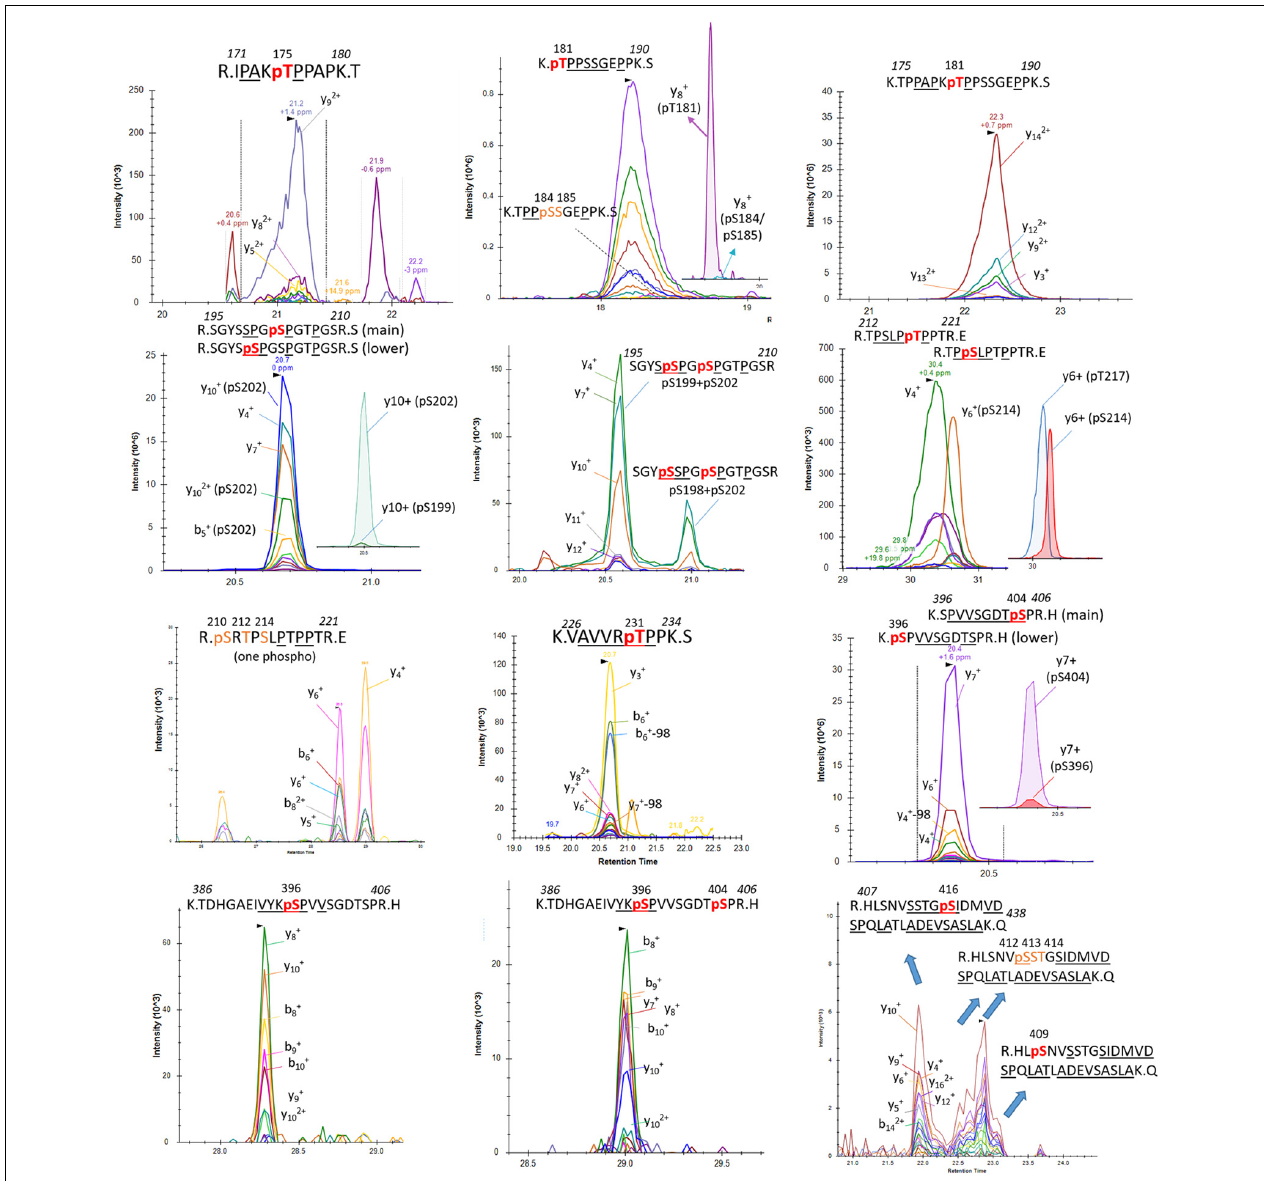
FIGURE 7 | Detection of phosphorylation sites in the mid-domain and C-terminus of brain p-tau